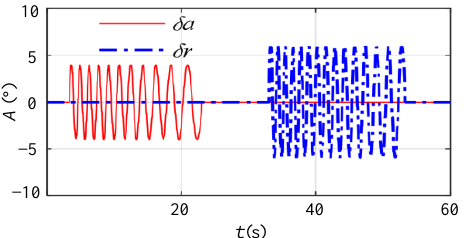
Figure 17. Lateral-directional excitation signal.